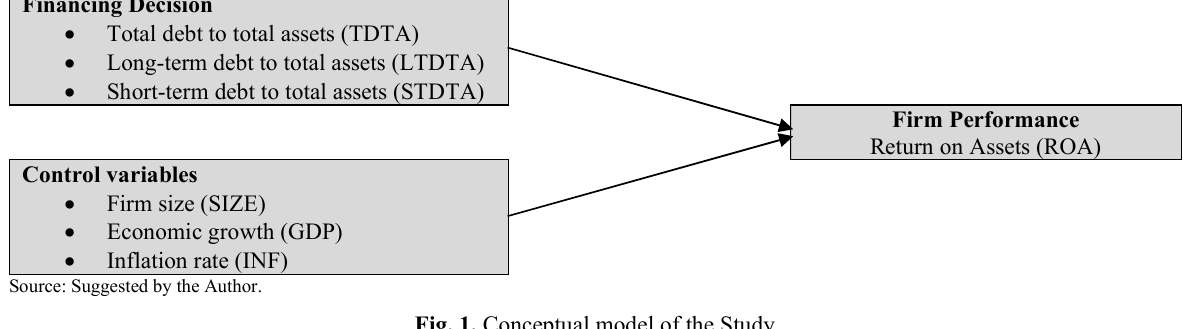
Fig. 1. Conceptual model of the